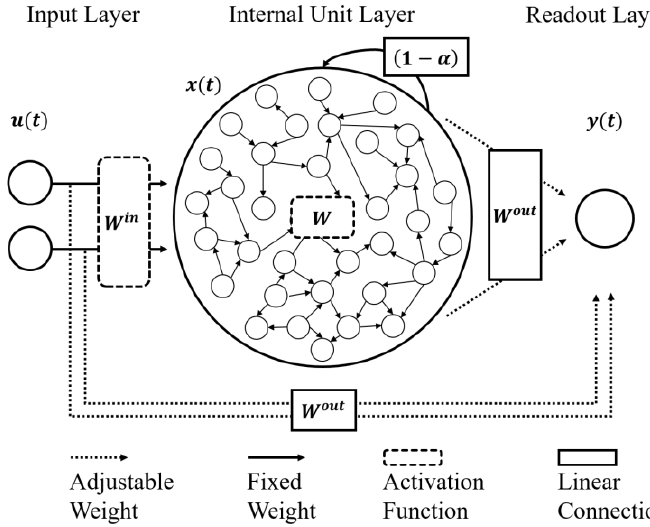
Figure 3. The structure of the echo state network (ESN). The ESN consisted of an input layer (2 input units in this study), an internal unit layer and a readout layer (1 readout). The units of the input layer were connected to the internal units with fixed weights. These internal units were recursively connected to each other with fixed weights. The units of the readout layer were linearly connected from the units of the input and the internal layers with adjustable weights (the figure was modified from [35]).